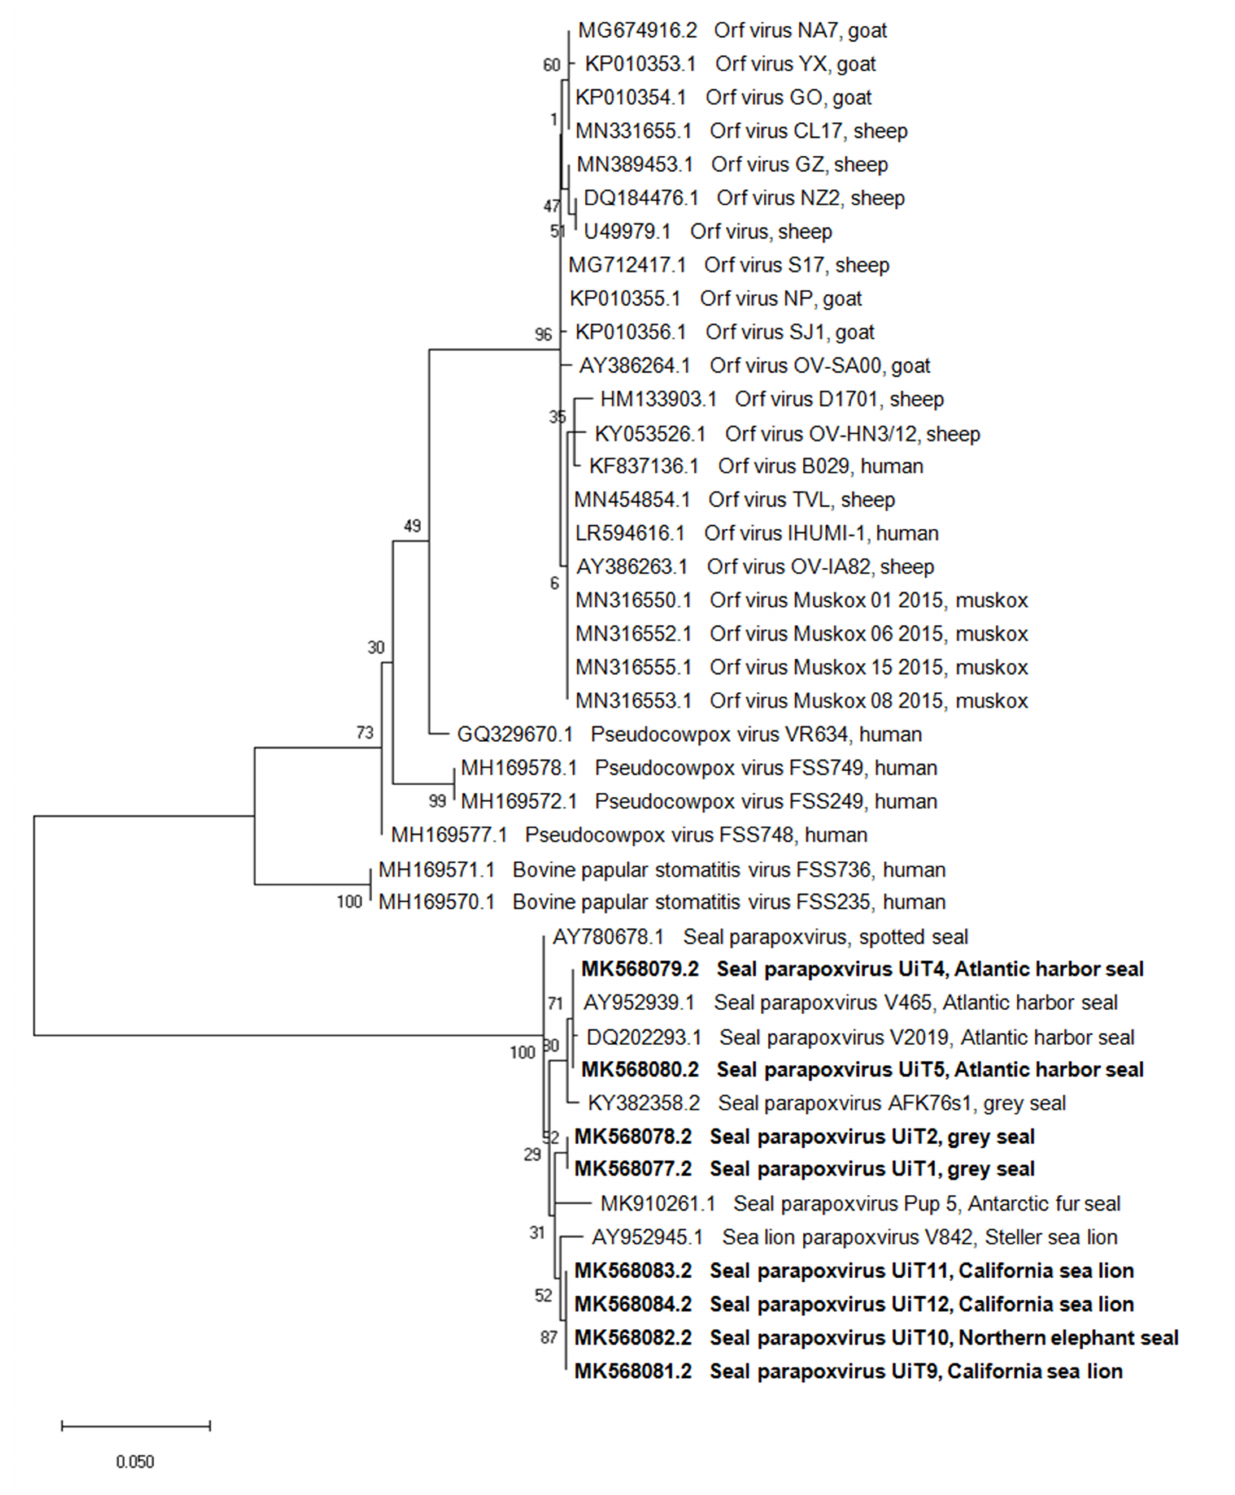
FIGURE 3 | Phylogenetic tree based on the partial nucleotide sequences of the DNA polymerase gene obtained in this study compared with corresponding DNA sequences from parapoxviruses published in GenBank. Isolates are described by GenBank accession number, parapoxvirus species and host species. The phylogenetic tree was constructed using the maximum-likehood method based on the calculation of the genetic distances between pairs of sequences using the Tamura 3-parameter model. The statistical support for the tree was provided by 1,000 bootstrap replicates with the respective percentages indicated on the branches. The scale bar corresponds to 0.05 aa substitutions per site. Sequences obtained in this study are shown in bold.